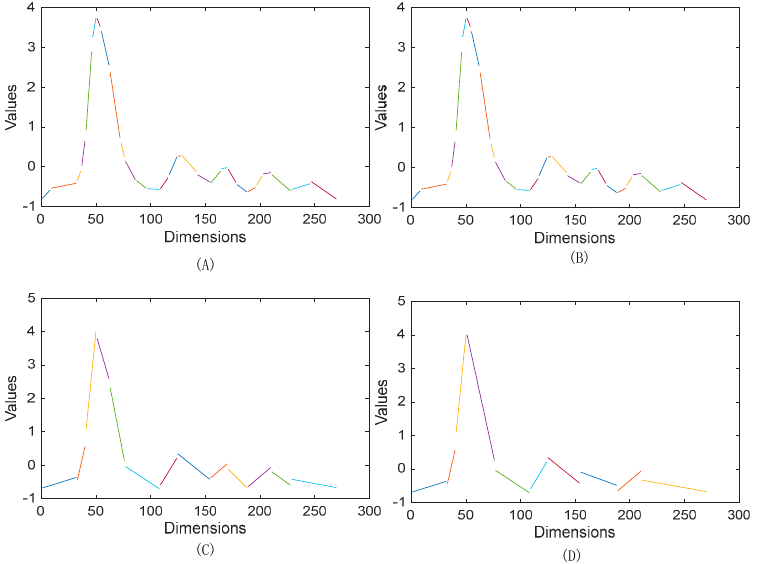
Figure 1. The least-squares fitting in different max_error on a 50 Words dataset. ( A ) the origin data; ( B ) max_error = 0.1; ( C ) max_error = 0.5; ( D ) max_error = 1.